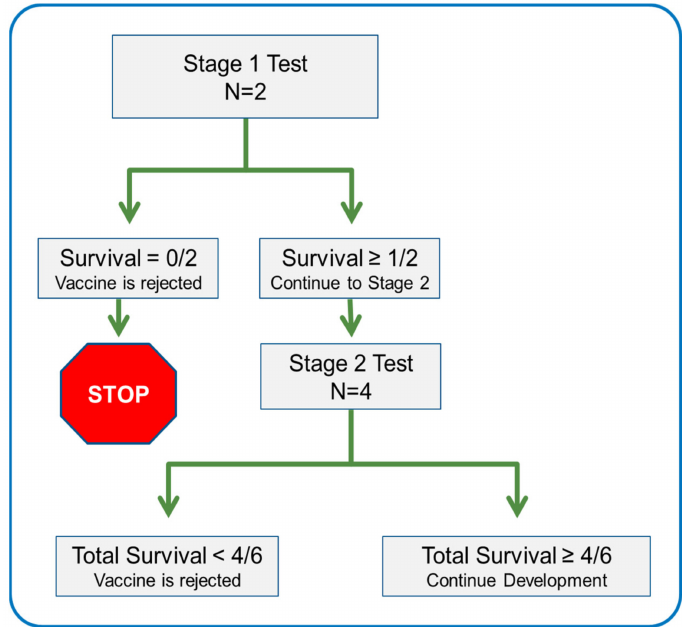
Figure 1. Decision tree for optimal Simon’s two-stage testing of vaccine